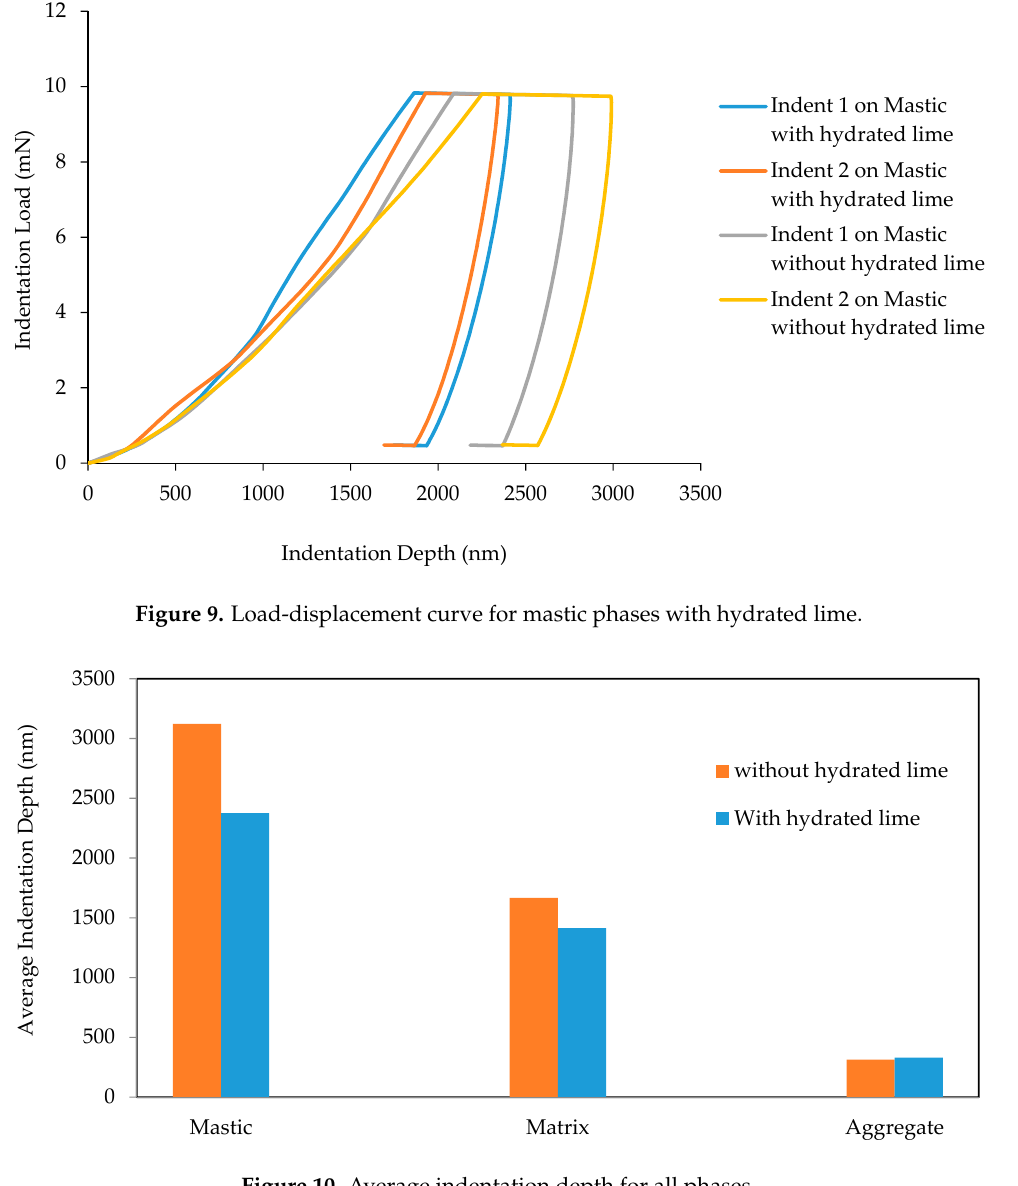
Figure 10. Average indentation depth for all phases.